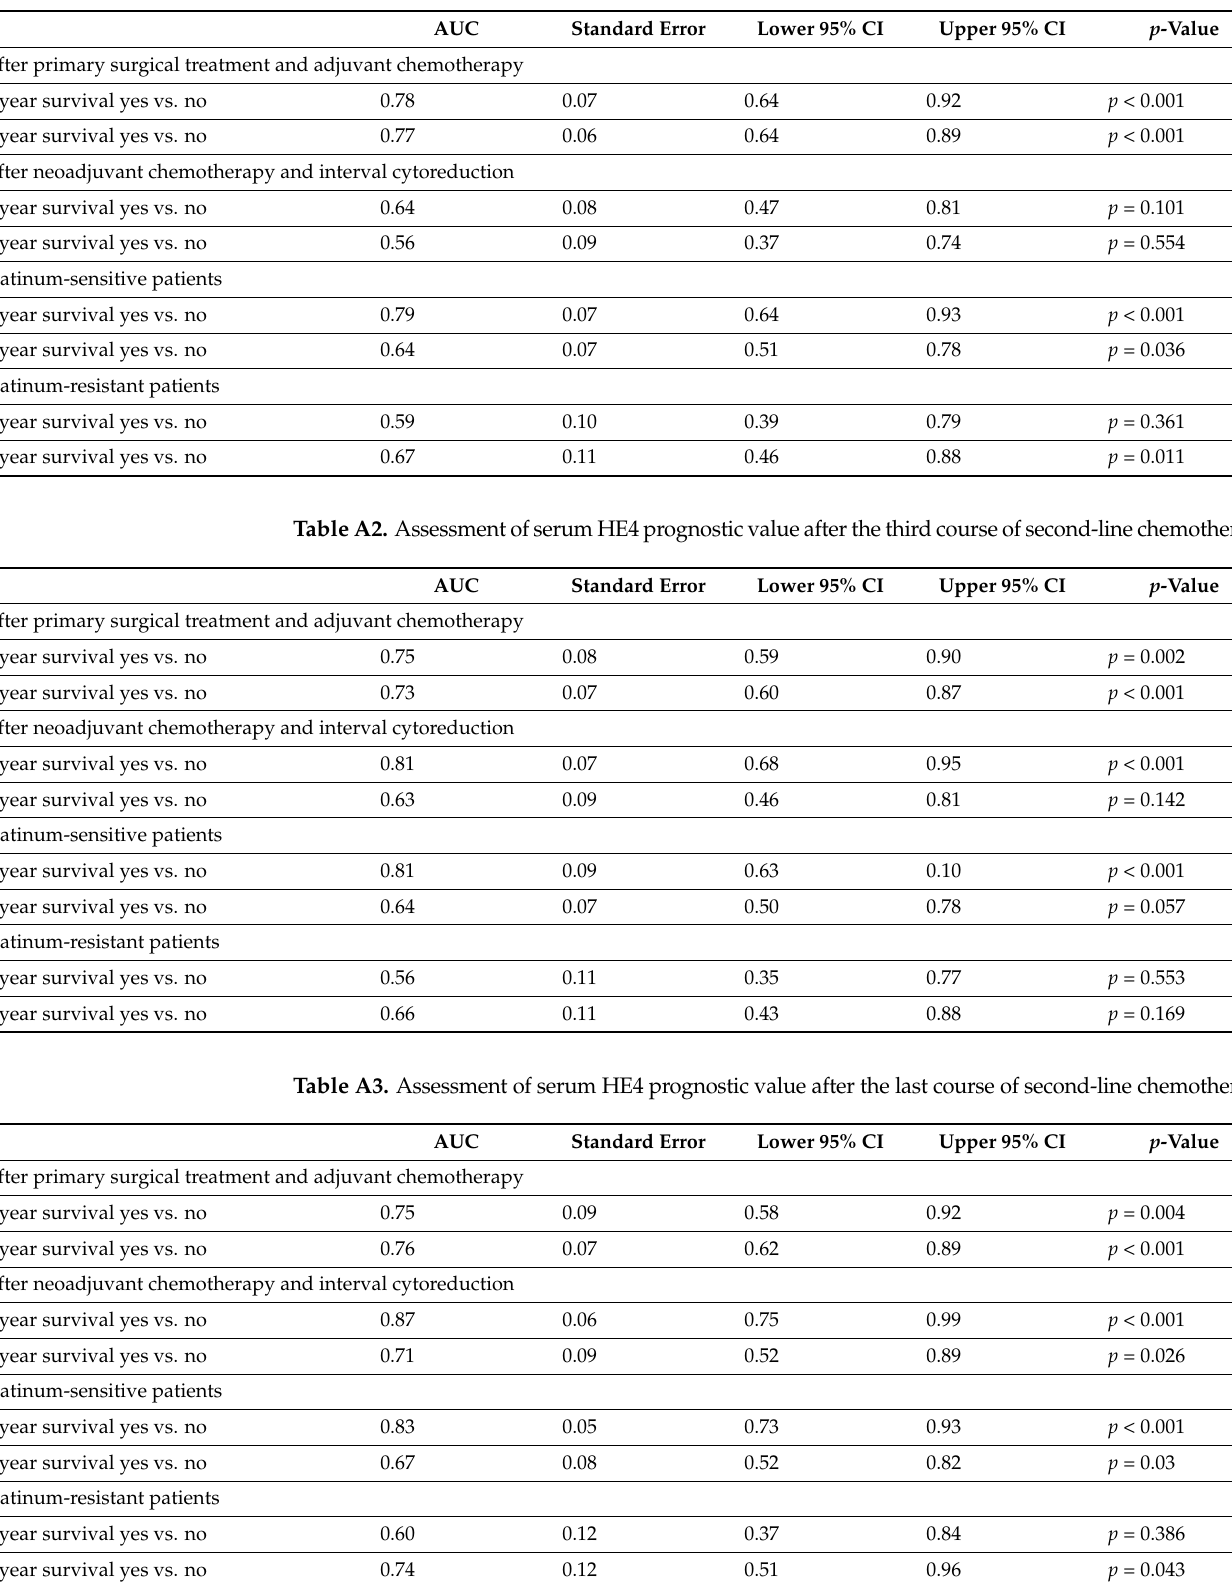
Table A1. Assessment of serum HE4 prognostic value at the time of OC diagnosis and recurrence.